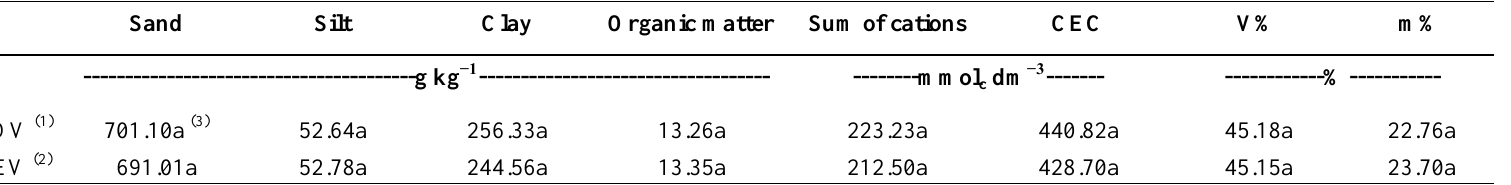
Table 2. Comparison of mean (t-test) of soil attributes values determined by traditional analysis and by sensor